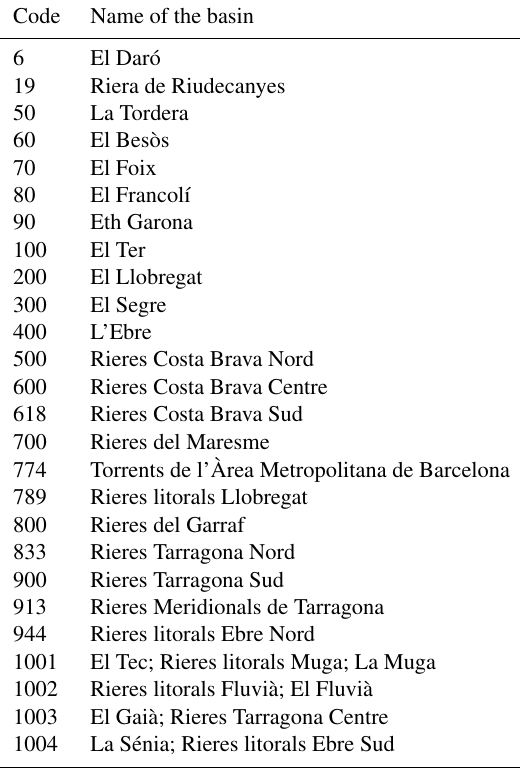
Table A1. Corresponding names of the codes of the basins of Catalonia region.